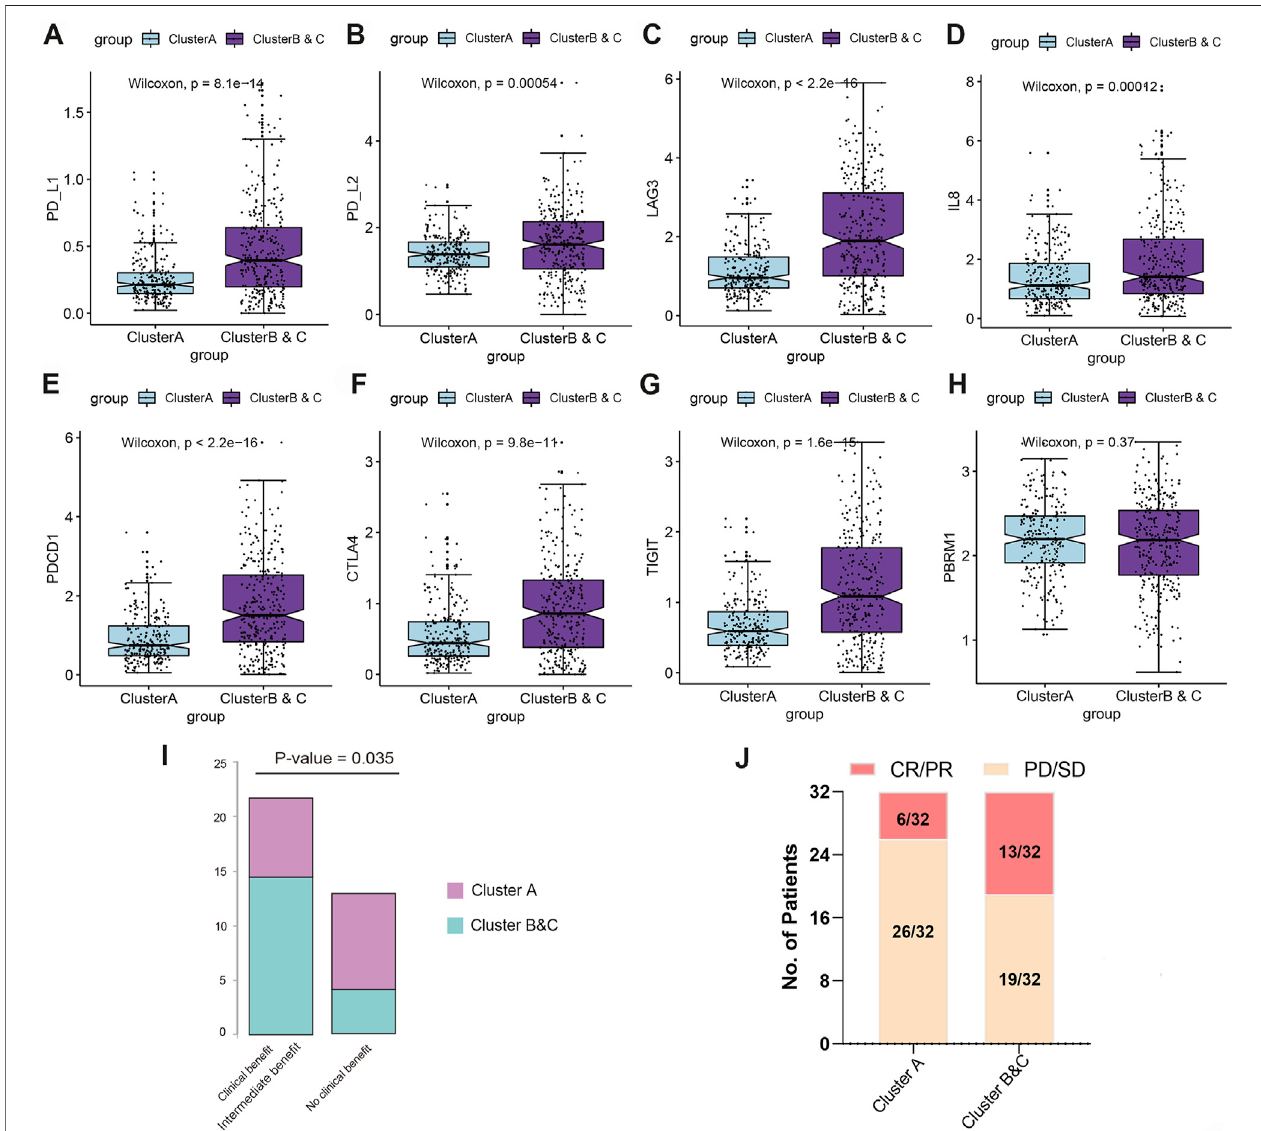
FIGURE 7 | Immunotherapy ef fi cacy analysis of immunophenotyping clusters. (A – H) Expressions of immune checkpoint molecules, including PD-L1, PD-L2, LAG3,IL-8,PDCD1,CTLA-4,andTIGIT,andPBRM1,werecomparedusingStudents ’ t test. (I) Atotalof35ccRCCpatientsreceivingICTsfromtheCA209-009cohort with RNA-seq data and clinical responses to treatment. (J) Response status in 64 ccRCC patients receiving ICTs alone or combined with TKIs from the FUSCC cohort.